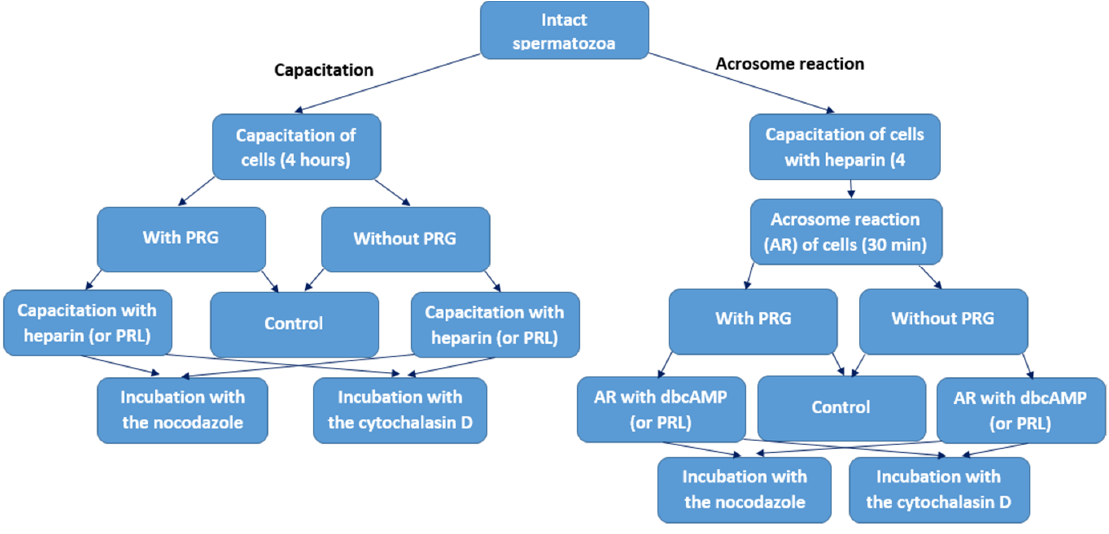
Figure 1. Study design.